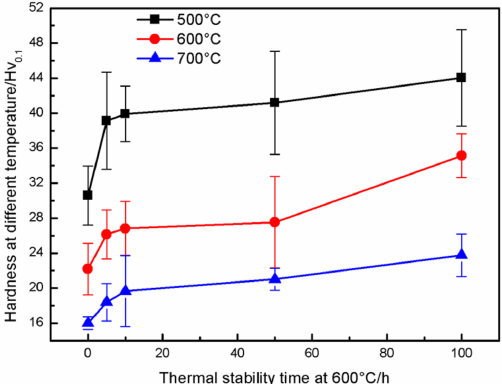
Figure 10. Effect of the thermal stabilization time on high temperature hardness of the CuAl seal coating.